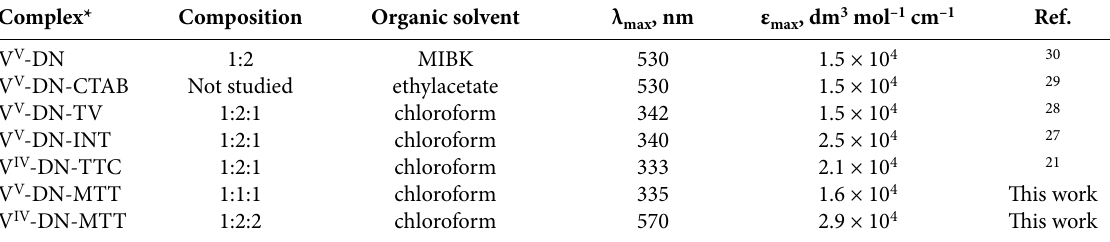
Table 2. Influence of the cationic ion-association reagent on the complex’s characteristics